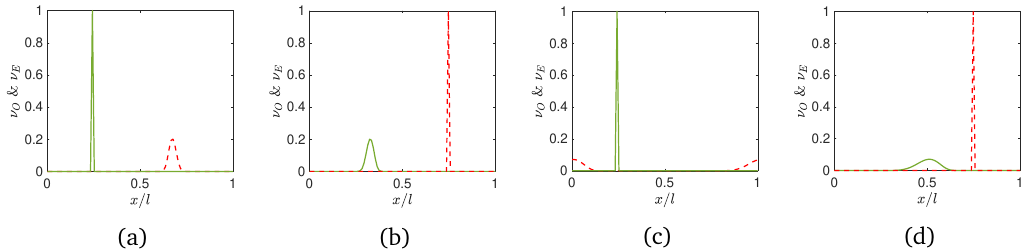
Figure 13: Distribution of the (chiral) operator evolution ν (green solid lines) and O the distribution of (chiral) energy density peaks ν (red dashed lines) within one E wavelength of deformation. In all the plots, we consider the random driving with two Hamiltonians H and H with probabilities 1 / 2 and 1 / 2. For H we A B A